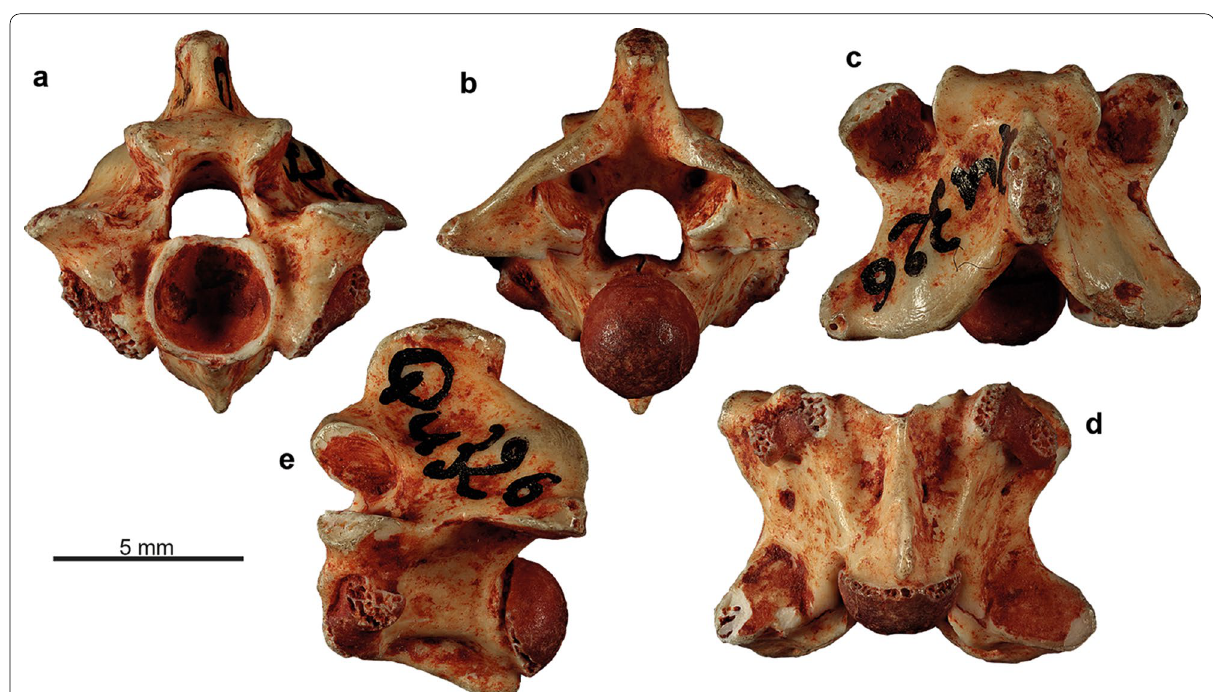
Fig. 40 “ Palaeopython ” neglectus from an imprecisely known locality in the Phosphorites du Quercy, lectotype: trunk vertebra (MNHN.F QU16326) in anterior ( a ), posterior ( b ), dorsal ( c ), ventral ( d ), and left lateral ( e )